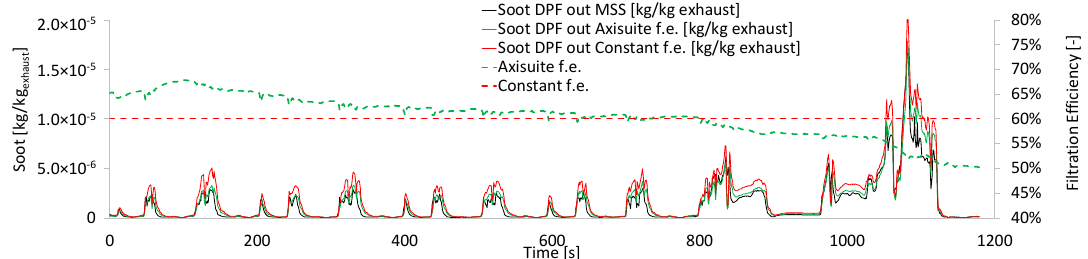
Figure 13. DPF-out soot emissions calculated based on the constant filtration efficiency and the filtration efficiency calculated by the Axisuite model. The comparison to the MSS measurement, reveals the advantage of the Axisuite model.